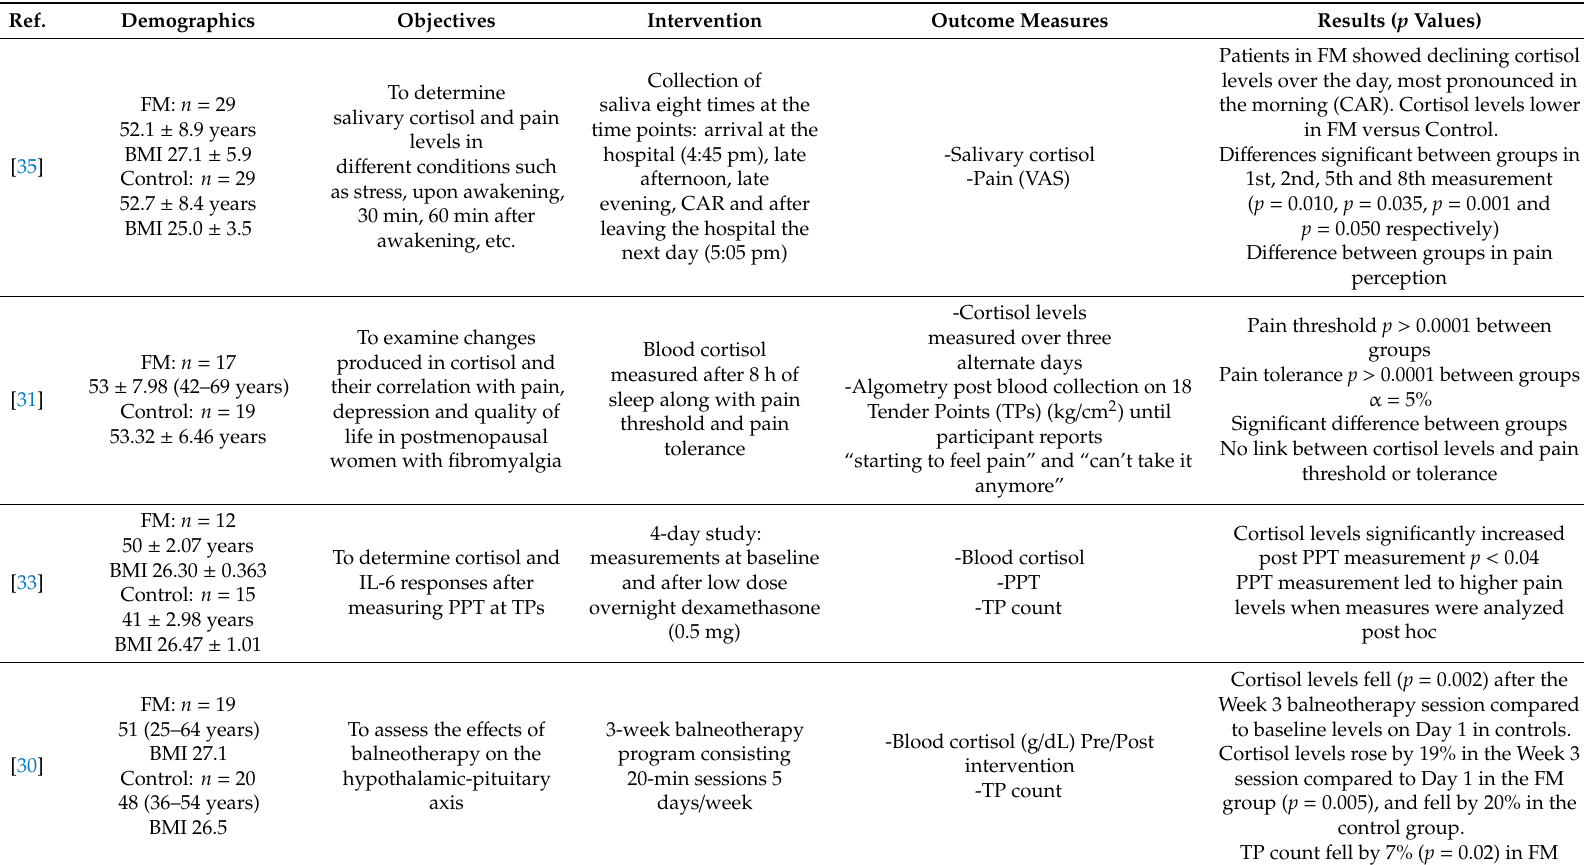
Table 2. Characteristics and results of the studies